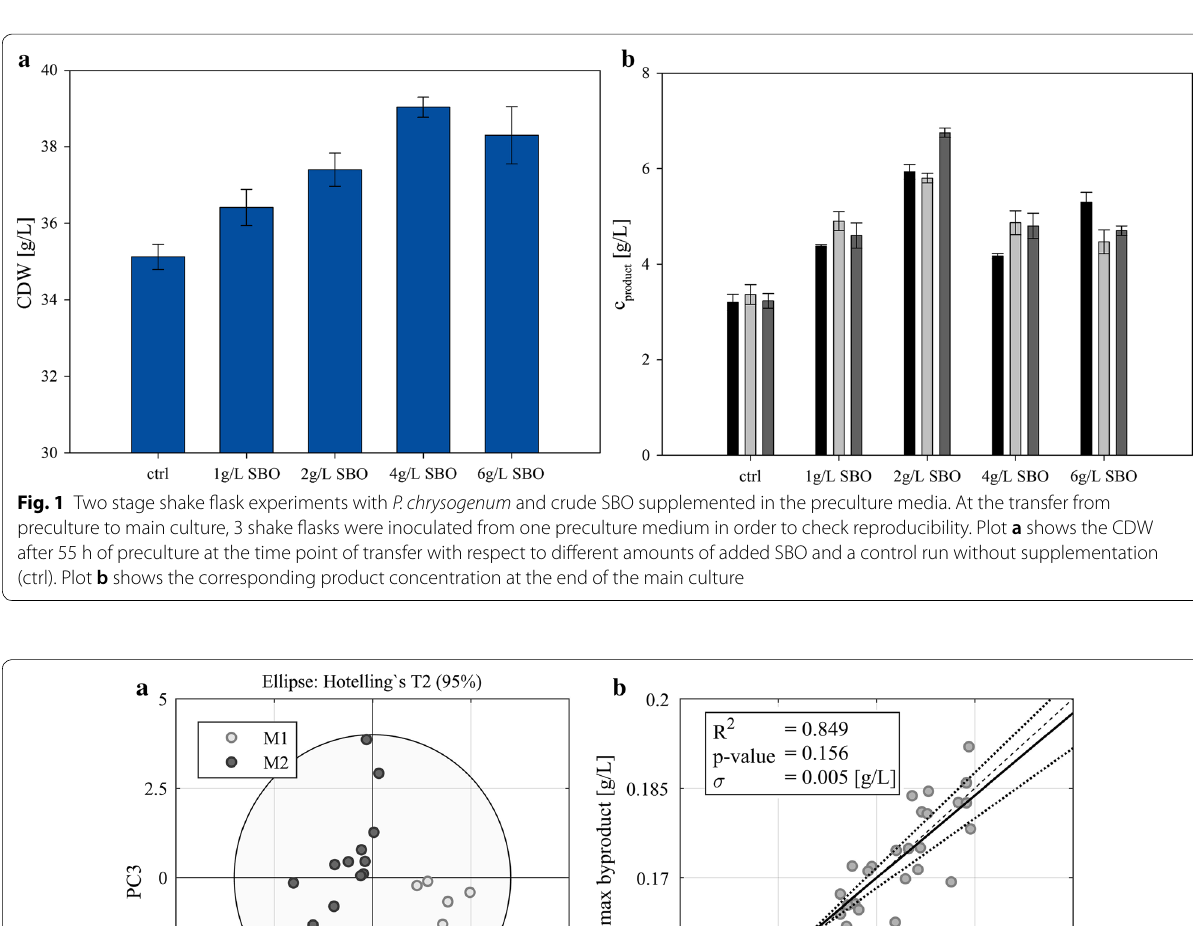
(Fig. 2a). Analysis of the production data and the spe- cific SBO composition by PLS showed that there was a certain correlation between the SBO composition and the formation of unwanted byproducts (Fig. 2b) as well as maximum product titer (data not shown). Clearly,